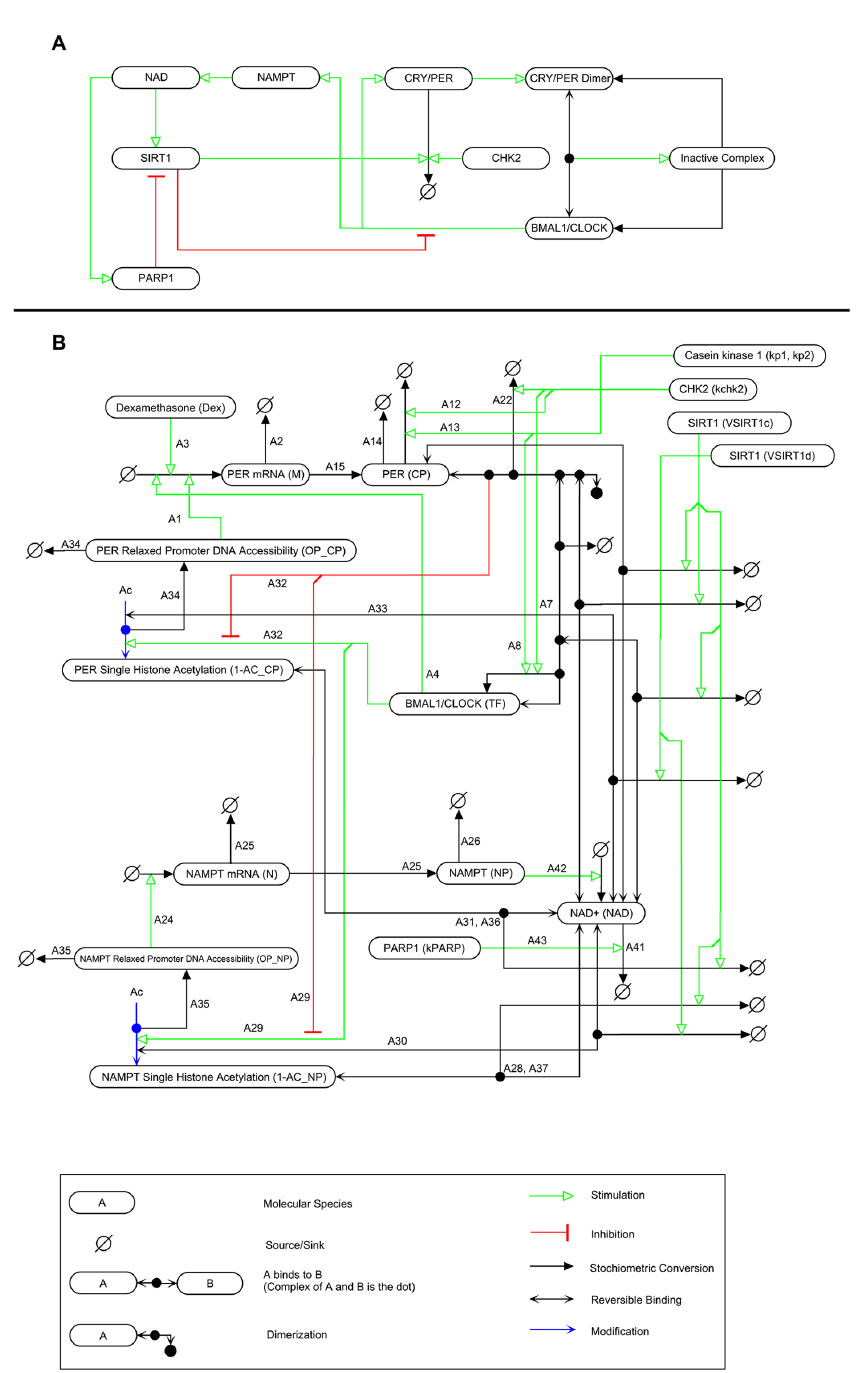
Fig 1. Molecular Interaction Map (MIM) wiring diagram of the simulated system. A) A simplified diagram highlighting the key activities of model species. BMAL1/CLOCK stimulates the production of both NAMPT and CRY/PER. CRY/PER dimerizes and binds to BMAL1/CLOCK to form an inactive complex. CHK2 stimulates the degradation of CRY/PER. NAMPT stimulates the production of NAD which in turn stimulates the activities of SIRT1 and PARP1. SIRT1 stimulates the degradation of CRY/PER and inhibits BMAL1/ CLOCK transcriptional activity. PARP1 inhibits SIRT1 activity through consumption of NAD, and B) Full MIM representation of